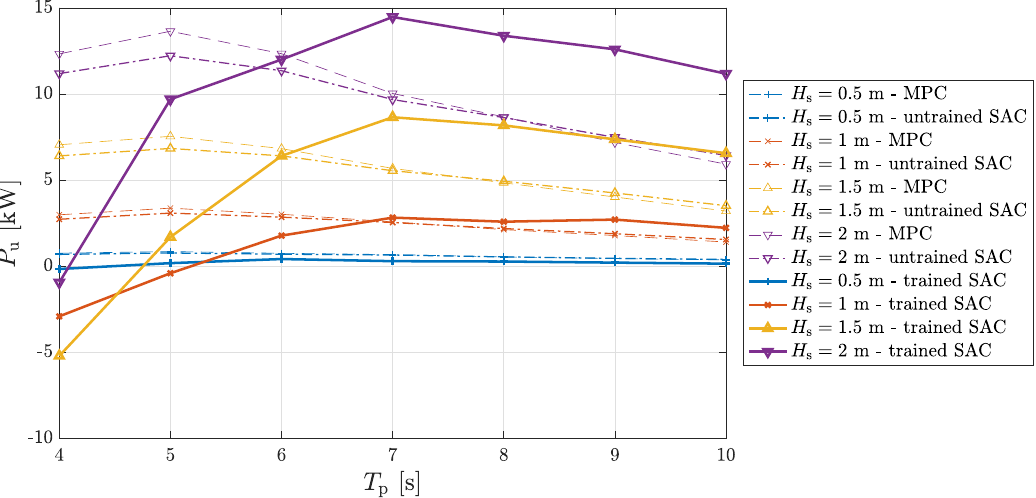
Figure 5. Variation with peak wave period of the mean useful power absorbed by the heaving sphere for the considered range of significant wave height.